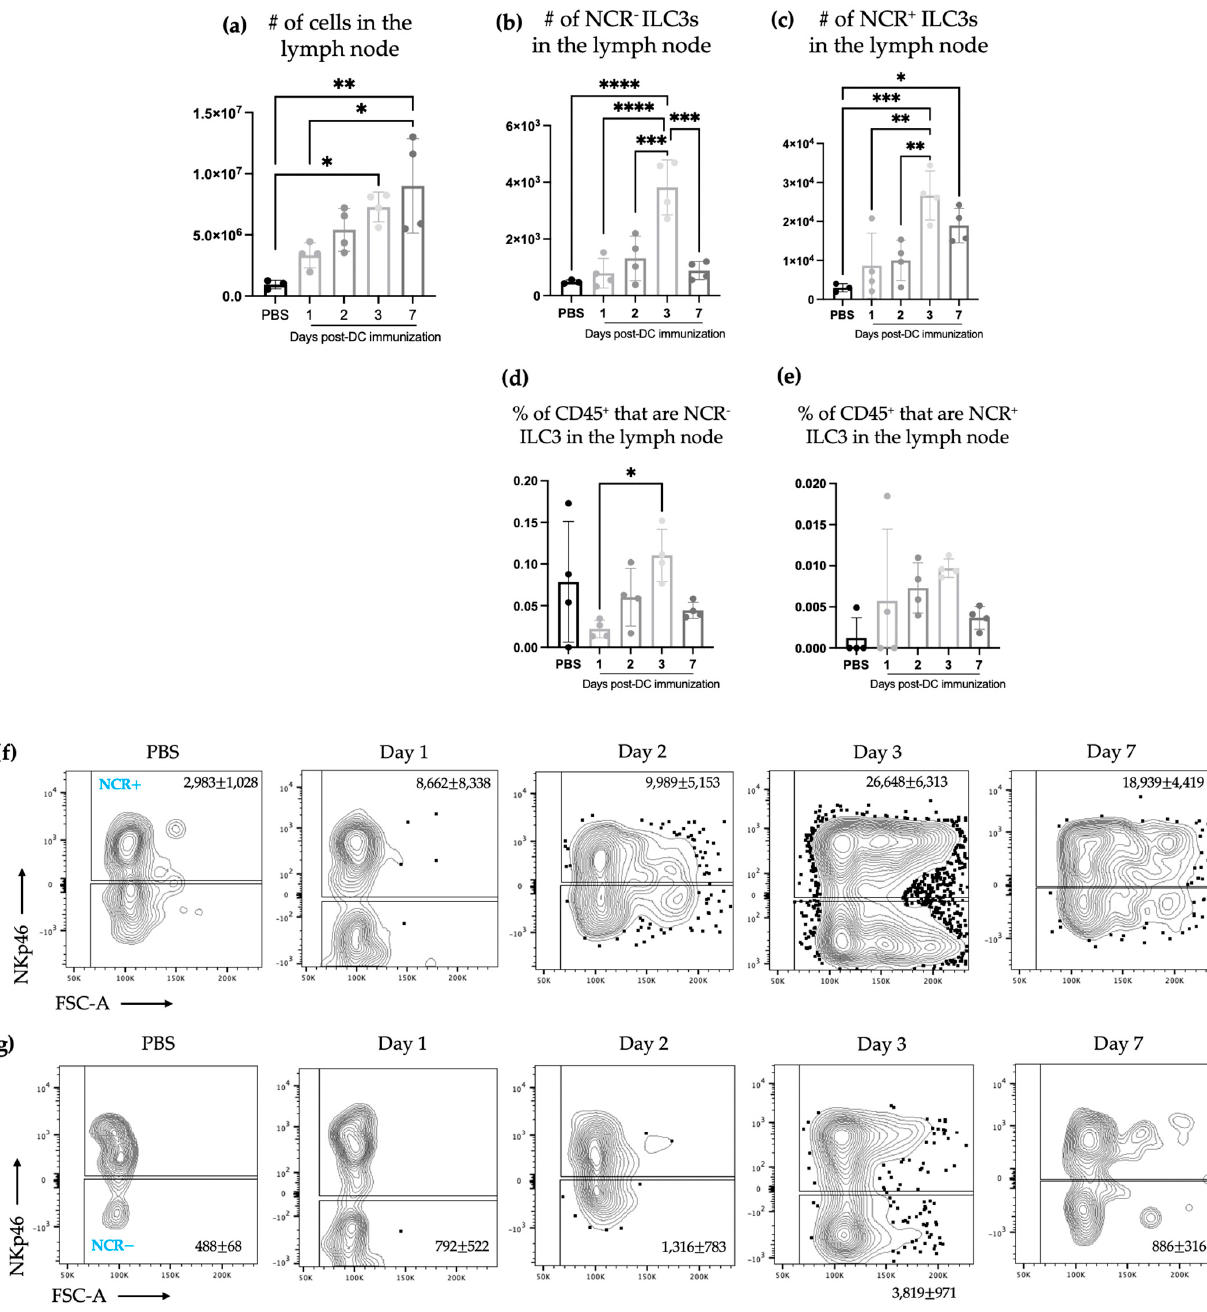
Figure 1. The number of natural cytotoxicity receptor (NCR) + and NCR − type 3 innate lymphoid cells (ILC3s) increased in the local draining lymph node after DC immunization. Female C57BL/6 mice were inoculated with DC vaccines via hind footpad injections. Popliteal lymph nodes were examined for ILC3 populations. ( a ) The total number of cells in the lymph node was determined. Accumulation of ( b ) NCR − ILC3s and ( c ) NCR + ILC3s in the lymph node and the percentage of CD45 + cells in the lymph node that were ( d ) NCR − ILC3s and ( e ) NCR + ILC3s. Each bar represents data from four popliteal lymph nodes. A Student’s t -test was used at each time point to determine significant differences between the control mice inoculated with phosphate-buffered saline (PBS) and the mice inoculated with the DC vaccine ( p -values * < 0.05, ** < 0.005, *** < 0.0005, and **** < 0.0001). Representative dot plots showing the average number of ( f ) NCR − ILC3s and ( g ) NCR + ILC3s in the draining popliteal lymph node. The graphs display the mean with the standard